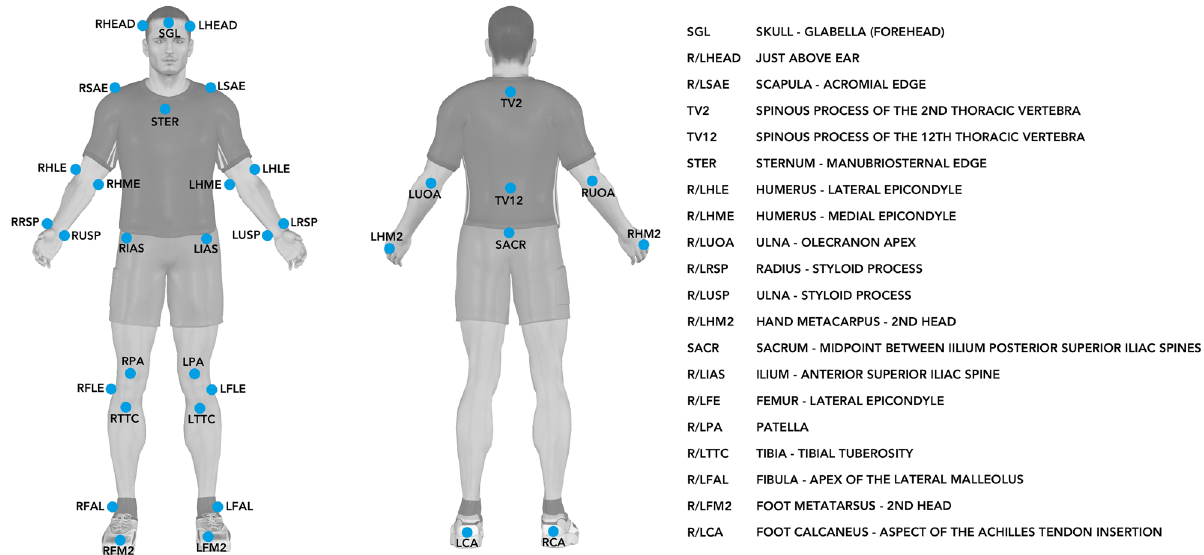
Figure 1. Retro-reflective markers ( N = 35) placed on anatomical landmarks of participants for biomechanical data collection. R and L at the start of the acronyms denote right and left,